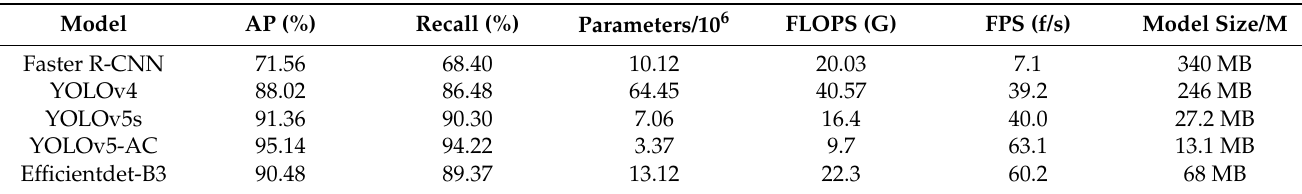
Table 7. Comparison of YOLOv5-AC and other models’